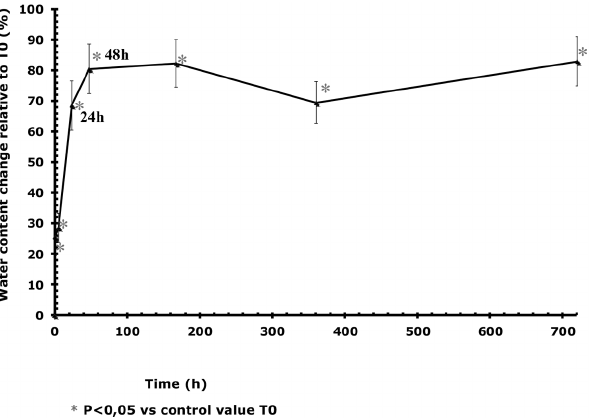
Fig. 2. Changes over time in percentage of water content of tablets stored at 25 ˚ C/60% RH in comparison with to T0. The vertical bars represent the 95% confidence interval limits for the measured water levels.